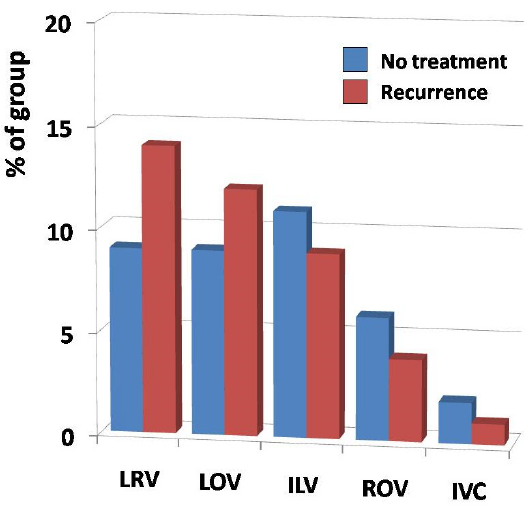
Figure 9. The prevalence of main anatomical variations and abnormalities (horizontal axis) in regards to their frequency (vertical axis) in analyzed groups. Abbreviations used: LRV—left renal vein, LOV—left ovarian vein, ILV—iliac veins, ROV—right ovarian vein, IVC—inferior vena cava.